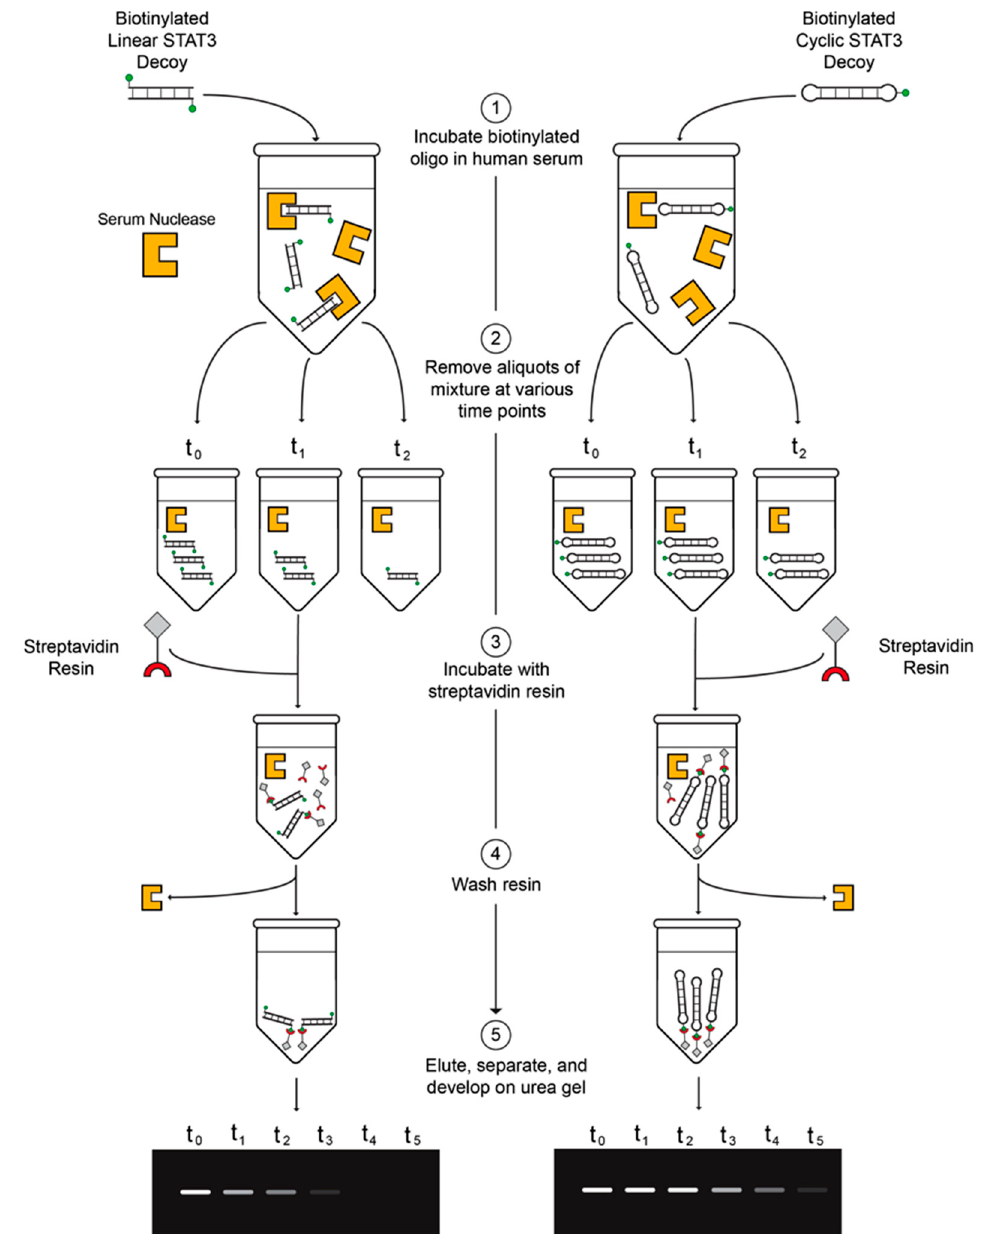
Figure 3. Diagram of the serum stability assay. (1) Incubate biotinylated oligodeoxynucleotide (ODN) in fresh human serum. (2) Remove aliquots of ODN/serum mixture at various time points and store in − 80 °C. (3) Incubate streptavidin resin with thawed aliquots of ODN/serum mixture. (4) Pellet and wash three times. (5) Elute by boiling, separate on urea/polyacrylamide gels, and develop with ultraviolet light.